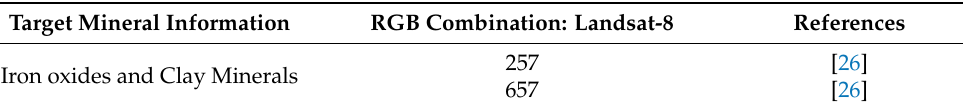
Table 3. RGB combination created using LANDSAT-8 imagery dated 25 February